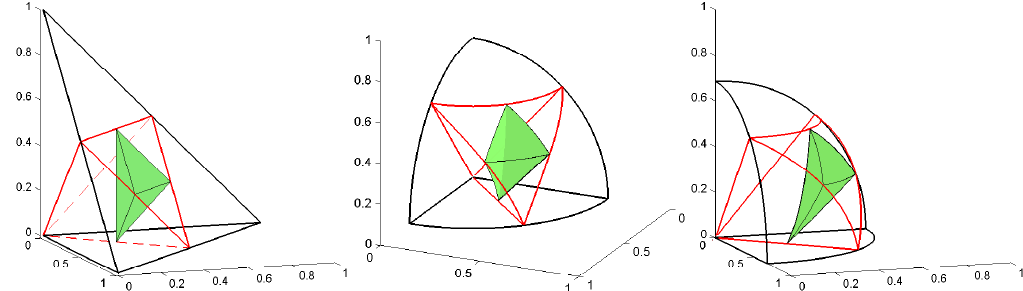
Figure 8. Left: a cell of M in red and a cell of T type in green from the octahedron Middle and right: the corresponding cells of the ball.